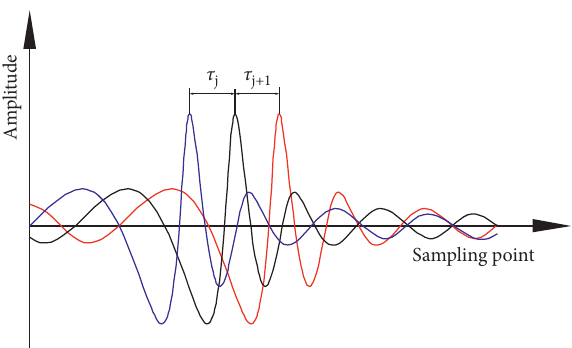
Figure 5: The offset τ of the intense change region in different periods W range i ( n j )